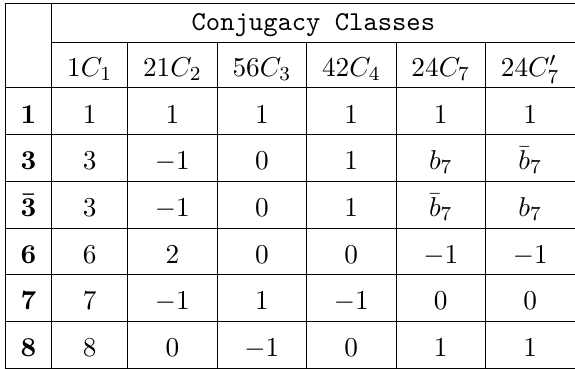
p 7) = 2 and (cid:22) b 7 = b (cid:3)